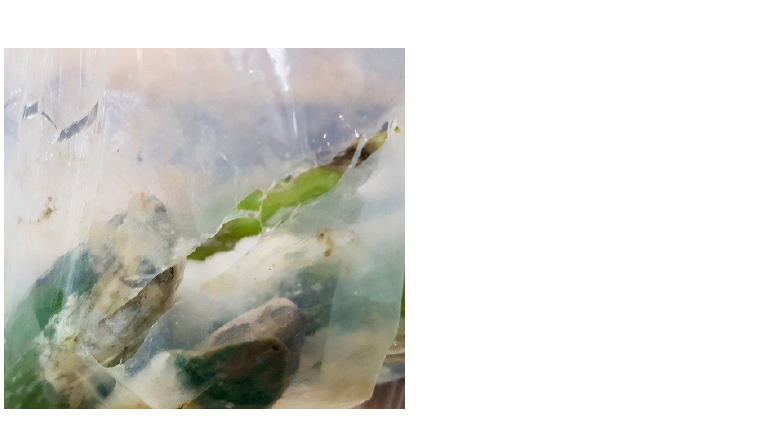
Figure 9. Effects of spolage organisims on the integrity of compostable packages.